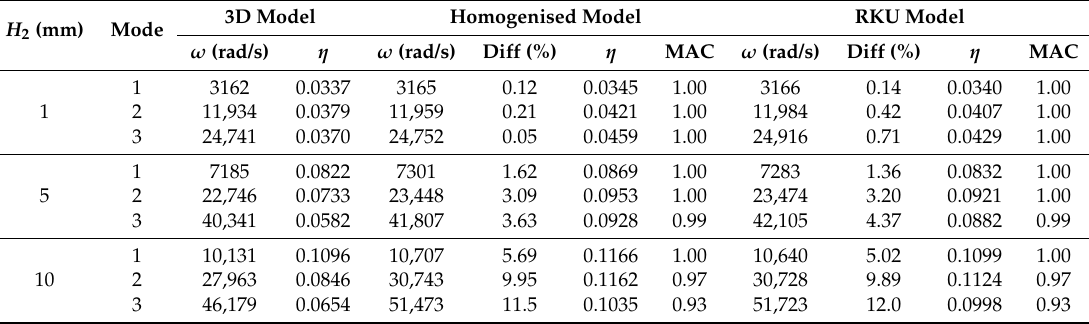
Table 3. Natural frequencies and loss factors of the simply supported CLD beam computed with the three models. For the beam models, the percent difference in the natural frequencies and MAC value with respect to the 3D model are also